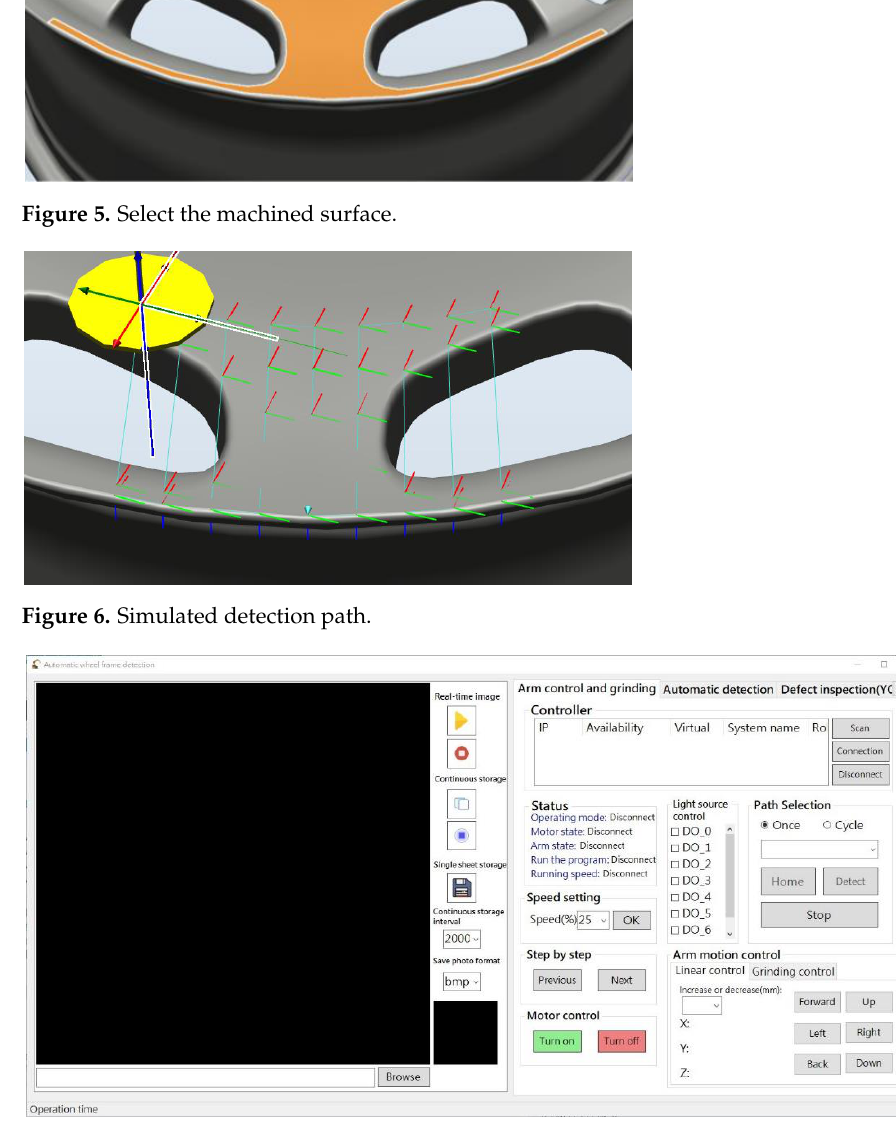
Figure 8. Automated detection interface. Figure 9. Test results interface. Our objective in this research was to automate the optical detection of defects in forged wheel rims. Experiments were designed to address (1) the collection of images showing examples of defects, (2) the methods used to expand the training dataset, (3) training of the convolutional neural network, (4) planning and simulation of the robot